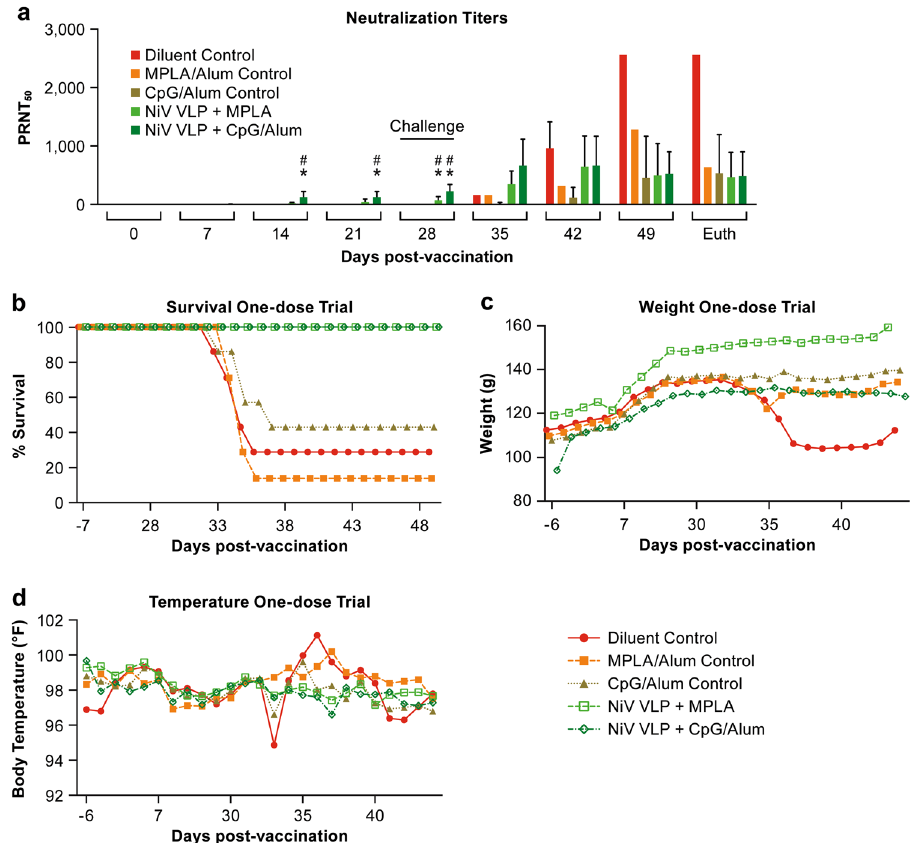
Fig. 4 Neutralizing antibody titers and survival following challenge in a single-dose vaccination regimen. a Serum collected from vaccinated animals was tested for the presence of neutralizing antibodies following vaccinations. The (*) indicates a group average statistically ( P < 0.01) greater than the diluent control for the same time point. The (#) indicates a group average statistically ( P < 0.01) greater than the day 0 sample for the vaccination group, b Survival, c Weight change and d temperature change following vaccination and after viral challenge at day 28. In b , c and d , each marker represents the mean for the